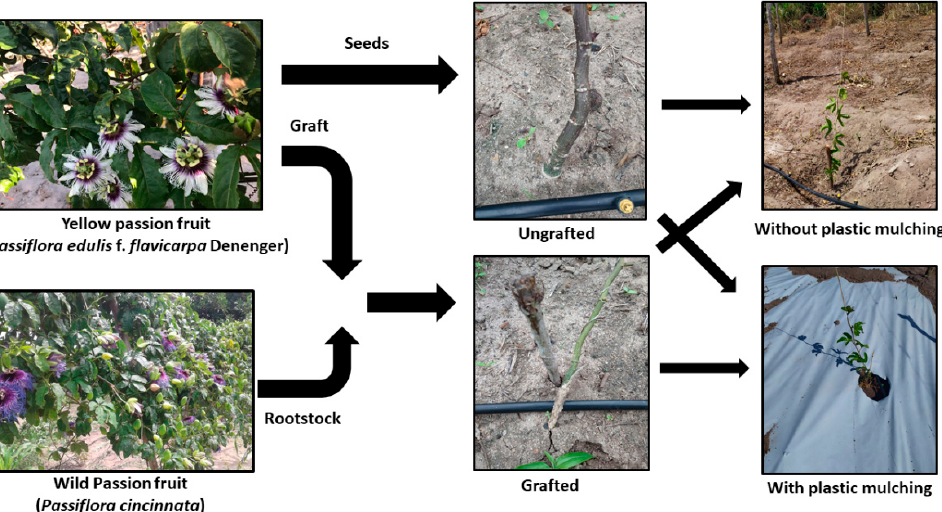
Figure 7. Experimental design of sour passion fruit propagated by seeds (SP) and grafted on P. cincinnata (GP) irrigated with low salinity (0.5 dS m − 1 ) and moderately saline (4.5 dS m − 1 ) irrigation water and grown in plastic-mulched and bare soil.